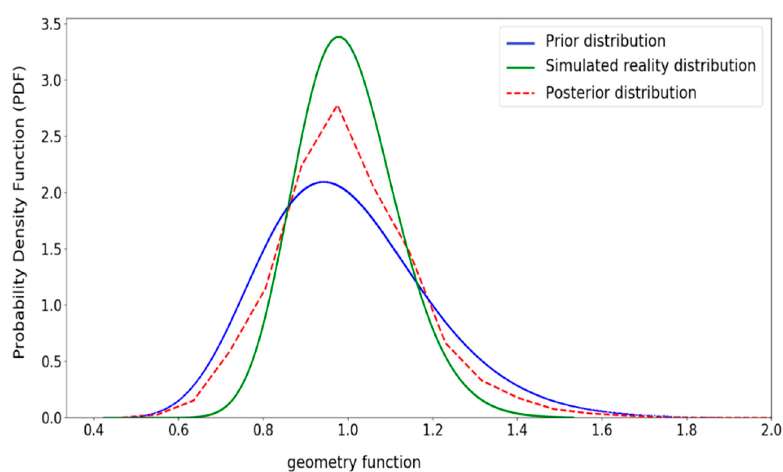
J. Mar. Sci. Eng. 2020 , 8 , x FOR PEER REVIEW Figure 18. Updated distribution for stress range (S) Figure 18. Updated distribution for stress range (S). Figure 18. Updated distribution for stress range (S)